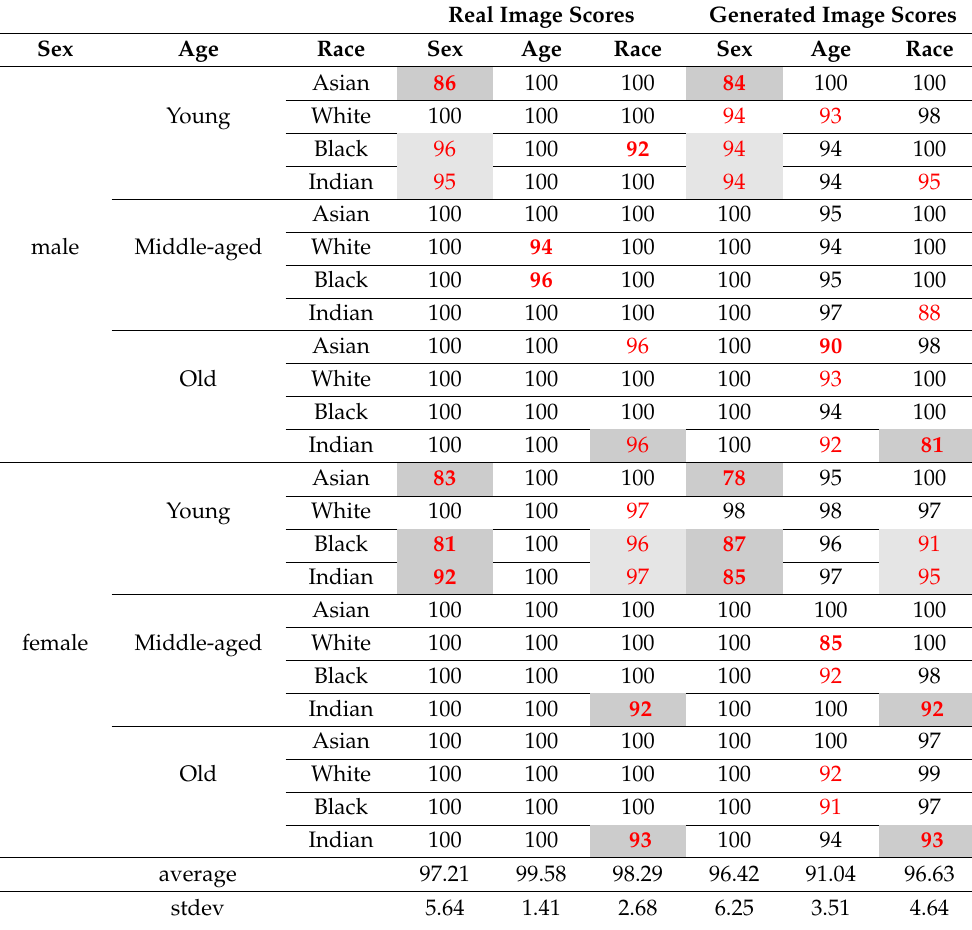
Table 5. Results of the user study: Scores of three attributes for each combination of attributes are presented. We compared these scores for real and generated images. Red bold figures denote those outside the average—standard deviation. The red figures denote they were in (average, average— standard deviation). Dark gray cells denote that the scores in the real and generated images were both red bold figures, and light gray cells denote that that the scores in real and generated images were red or red bold figures. Real Image Scores Generated Image Scores Sex Age